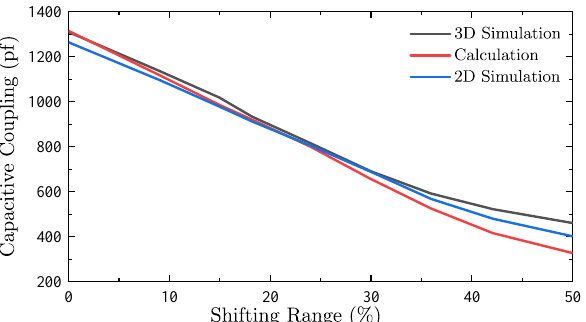
Figure 18. Capacitive coupling simulations and calculation results for different shifting ranges between layers. Since capacitive coupling also depends on the distance between the tracks, shifting can only be effective within a limited range in each design, as there may be repeated cases